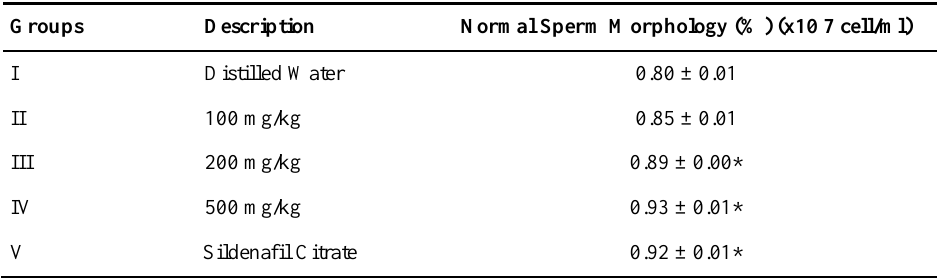
Table 1.4: Sperm Morphology for Groups I, II, III, IV and V